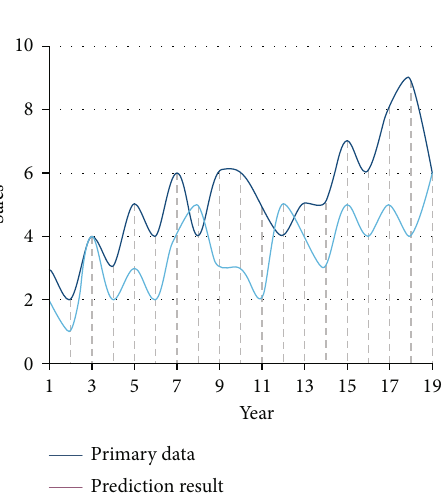
Figure 3: Sales trend chart.